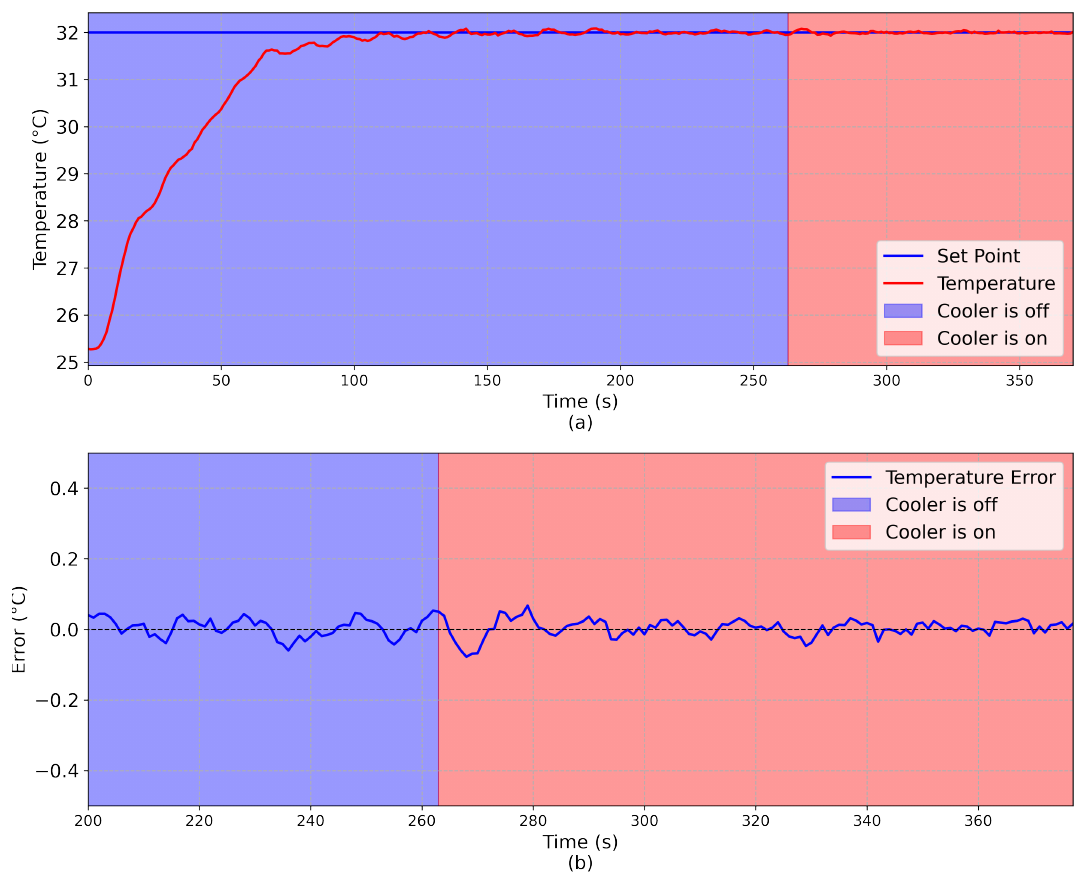
Figure 11. Fuzzy: ( a ) Comparison between the set-point (blue line) and the emulated temperature (red line). ( b ) Error (E = Set-Point - Emulated Temperature) during the noise test. The region with a blue background indicates that the cooler is off and the region with a red background indicates that the cooler is